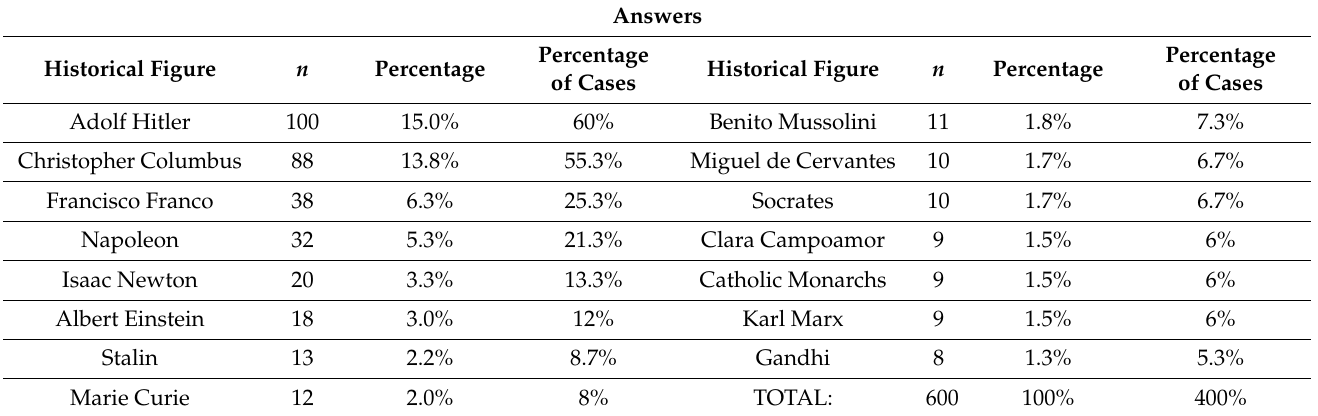
Table 1. Which figures do students think are historically relevant after completing their compulsory schooling?